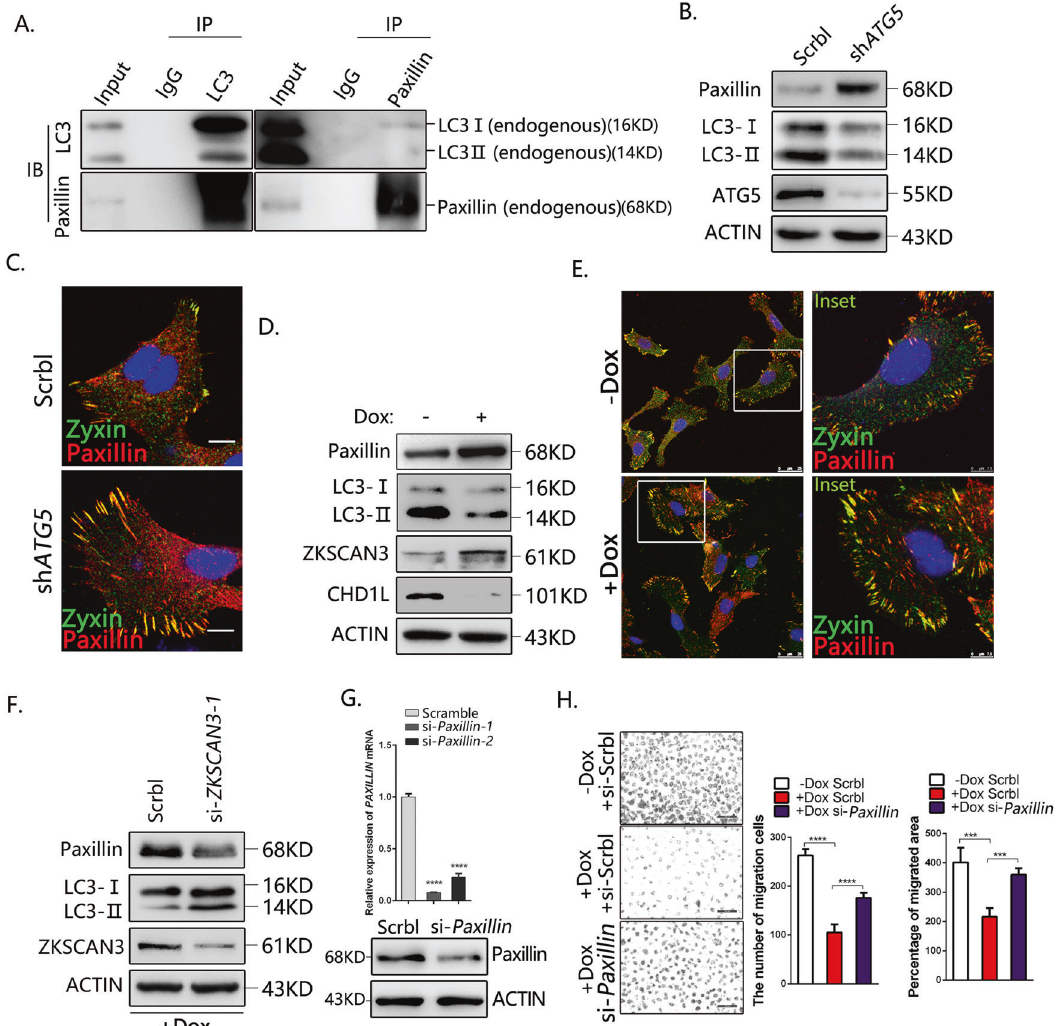
Fig. 7 CHD1L-ZKSCAN3 axis promotes HCC migration partially through autophagic degradation of Paxillin. A Co-IP assays of interaction between LC3B and Paxillin in QGY-7703 cells. The precipitates were examined with anti-Paxillin and anti-LC3B antibodies, respectively. B WB analysis for Paxillin accumulation in QGY-7703 cells treated with Sreamble or shRNA for ATG5 . C Immuno fl uorescence of FA proteins Paxillin and Zyxin in control and ATG5 silencing cells. Scale bars: 10 μ M. D WB analysis for Paxillin accumulation in QGY-7703 cells treated with or without Dox. E Immuno fl uorescence of FA proteins Paxillin and Zyxin in QGY-7703 cell with or without Dox inducing. Scale bars represent as shown. F Paxillin accumulation defects in CHD1L-depleted cells in response to ZKSCAN3 knockdown. Images/immunoblots are representative of three independent experiments. G The mRNA and protein level of Paxillin was analyzed in QGY-7703 cells treated with the most ef fi cient siRNA fragment for Paxillin (hereafter referred to as si- Paxillin ), compared with the scrambled control. H QGY-7703 cells with Dox treated were subjected to wound-healing assay and migration in response to Paxillin knockdown, compared with the scrambled control. Quanti fi cation of migration indicated group (**** p < 0.0001, Student t test; values are shown as mean ± SD calculated from three parallel experiments; n = 5). Scale bar as